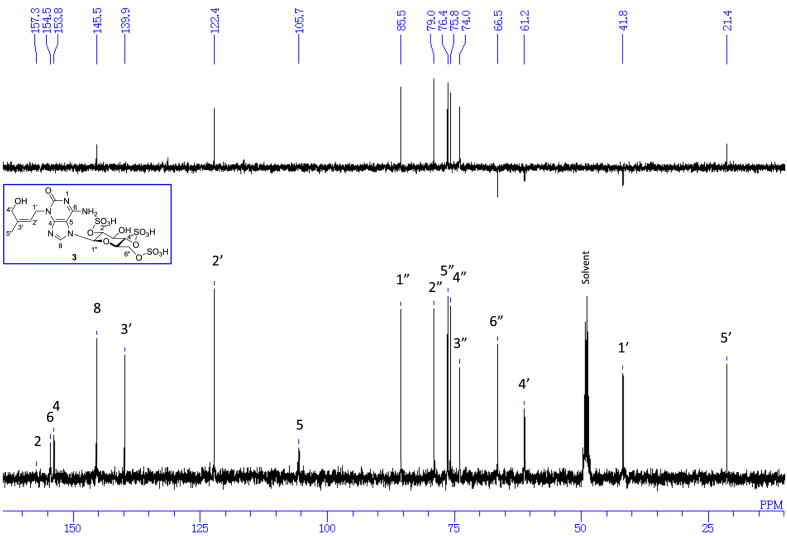
13C NMR and DEPT (100 MHz, CD3OD–D2O, 1:9) of 3.